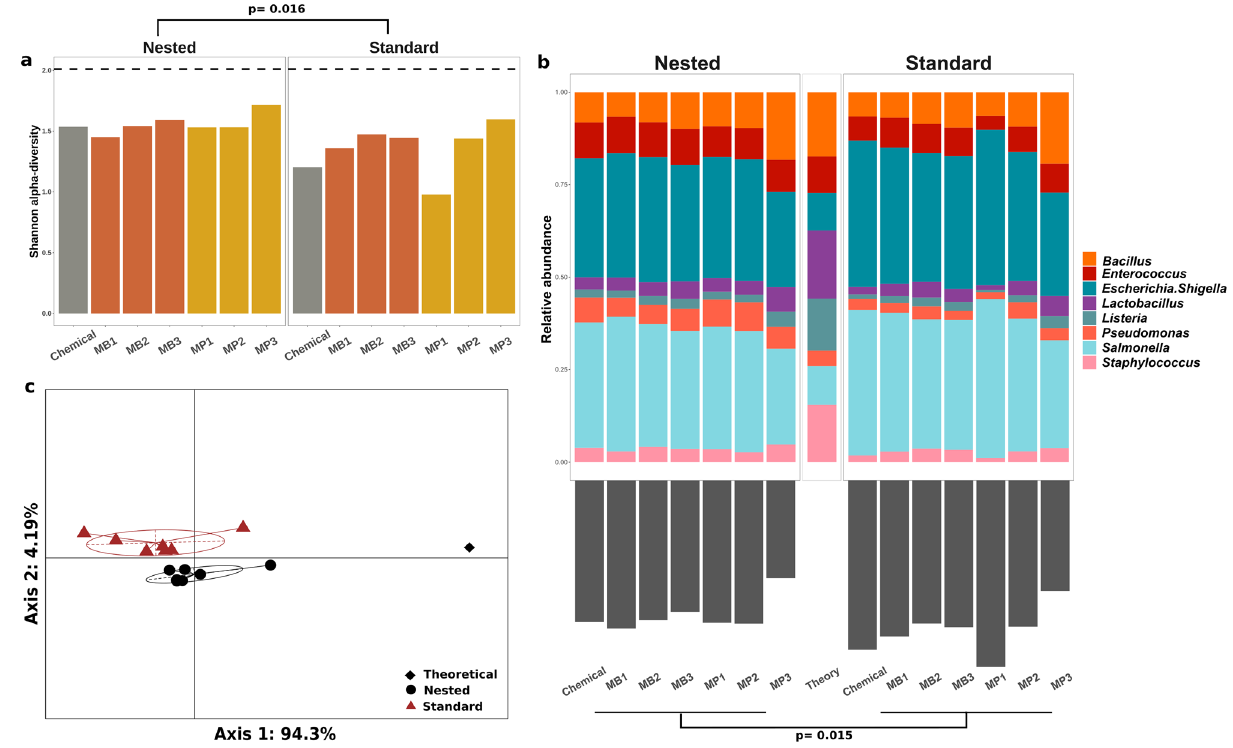
Figure 3. Extraction and PCR protocols effect on the representation of commercial mock microbial community standard composition. Microbial community standard was exposed to three DNA isolation methods (Chemical, Magnetic Beads (MB) and Miniprep kit (MP)), 3 mechanical lysing protocols (3 × 30 s, 2 × 5 min and 4 × 5 min, coined 1, 2 and 3, respectively) and two 16S rRNA gene PCR amplification protocols (Standard and Nested). Bacterial composition stratified according to DNA extraction and PCR was analyzed for ( a ) alpha-diversity (Dashed-line represents the theoretical Shannon index calculated with the supplier-furnished theoretical abundances), ( b ) Abundance profiles (upper panel) and Bray–Curtis distance between samples and theoretical composition (lower panel) and ( c ) Principal coordinate analysis (PCoA) based on Bray–Curtis distance discriminates between the two PCR protocols (colors). Paired statistical analysis was applied to investigate Alpha-diversity and Bray–Curtis distance differences between Standard and Nested PCR protocols (Wilcoxon test). Figures were generated using R 39